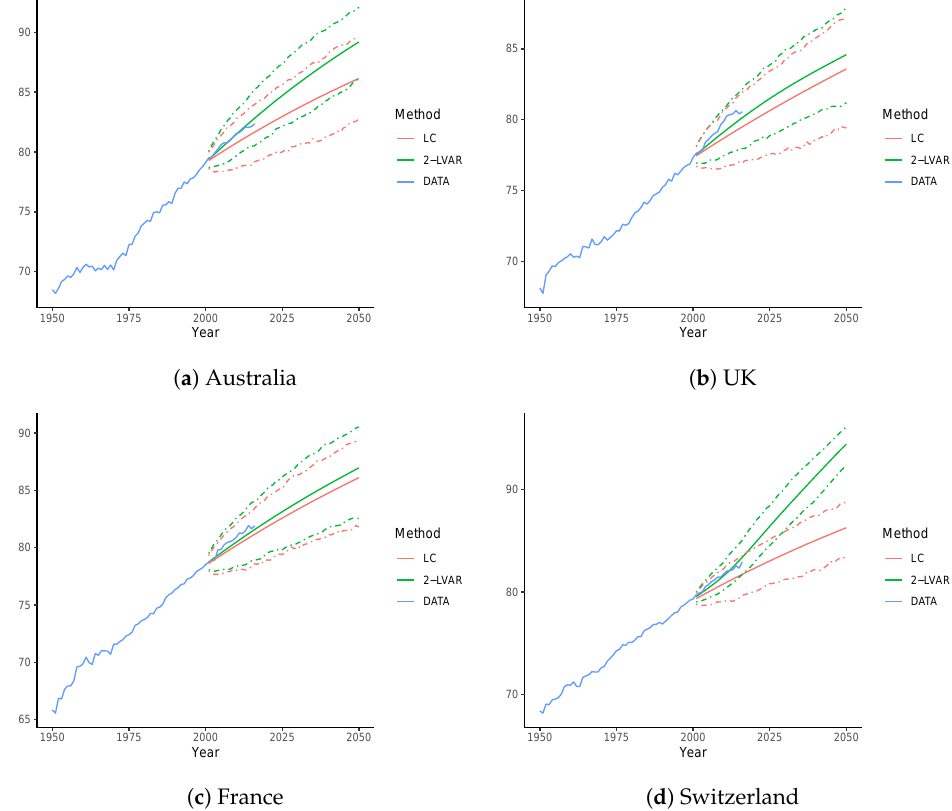
Figure 6. Forecast life expectancy at birth for Australia, the UK, France, and Switzerland using the LC and 2-LVAR models. The training sample includes 1950–2000. The life expectancy is forecast over 2001–2050. Dashed lines are the corresponding 95%